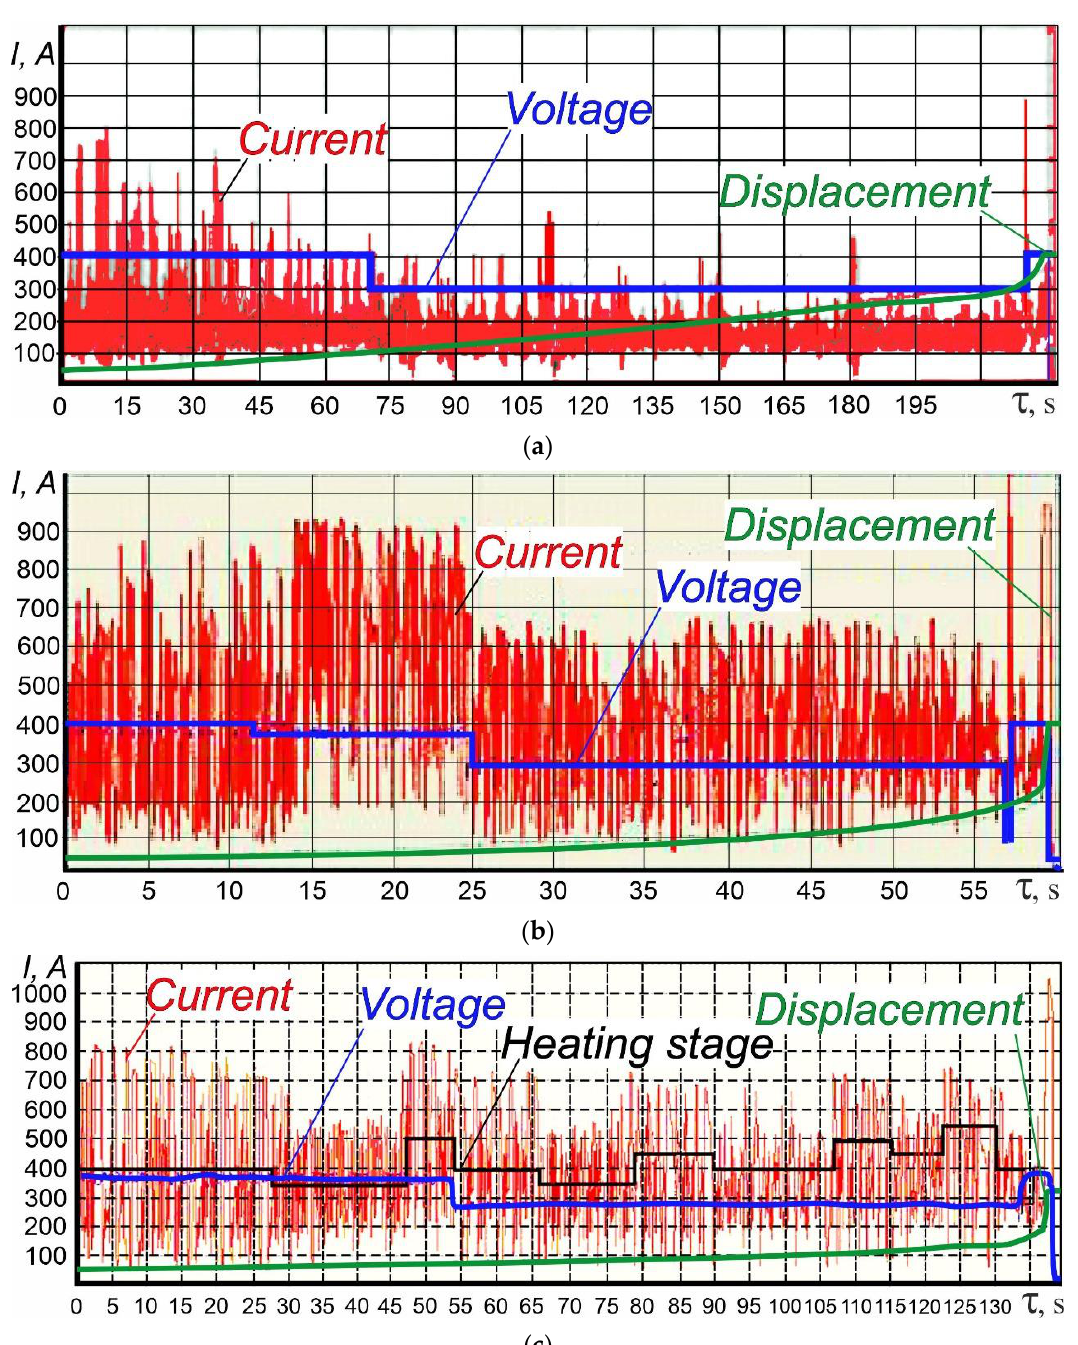
Figure 1. Oscillograms of the recording of the main welding parameters: average values of current, voltage and displacement. ( a ) continuous flash welding; ( b ) pulsating flash welding; ( c ) combined flash welding.